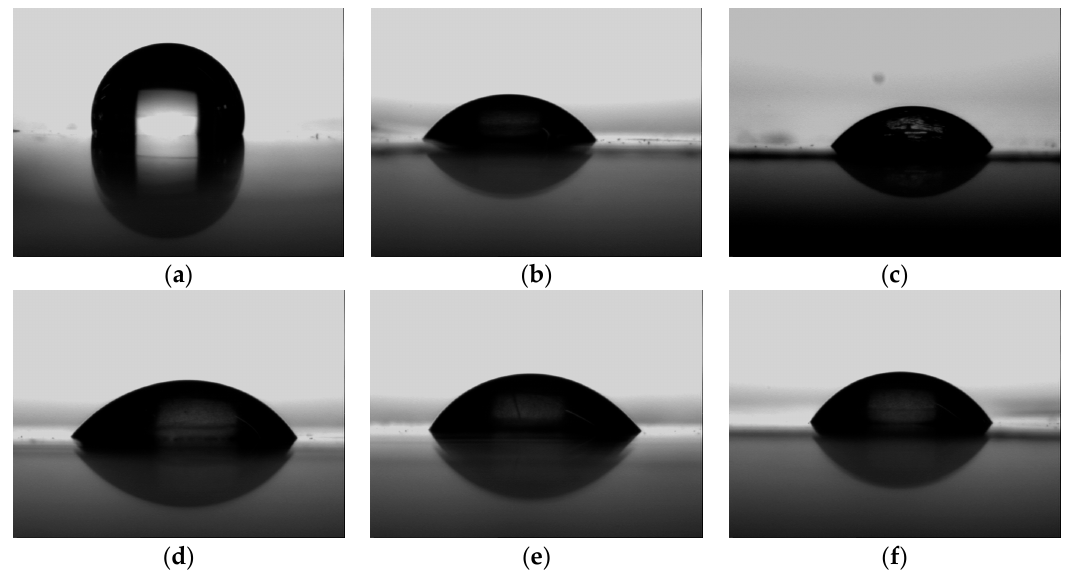
Figure 4. WCAs of DBD pre-treated PEs ( a : pristine PE, 102.4°; b : Ar plasma, 57.1°; c : O 2 plasma, 55.9°; d : Ar+allylamine, 51.4°; e : Ar+acrylic acid, 53.6°; f : Ar+ethanol, 60.2°).